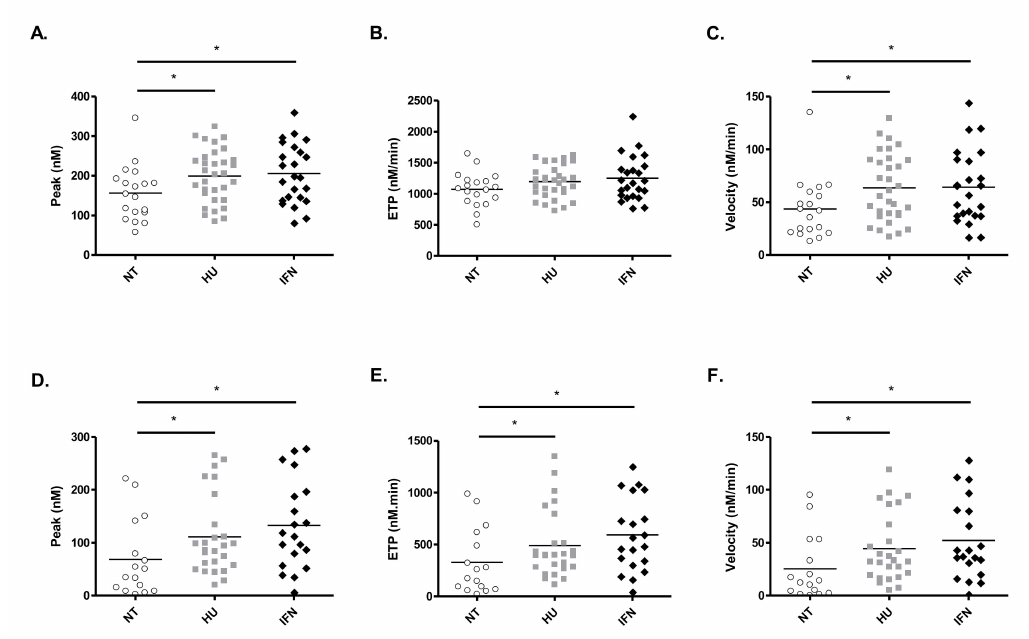
Figure 3. Thrombin generation in the plasma of NT, HU- and IFN-treated patients in the absence ( A – C ) and in the presence ( D – F ) of thrombomodulin. Peak of thrombin ( A , D ), ETP ( B , E ), and velocity ( C , F ). Post-hoc pairwise comparisons of parameters were performed using the Mann–Whitney test. * p <